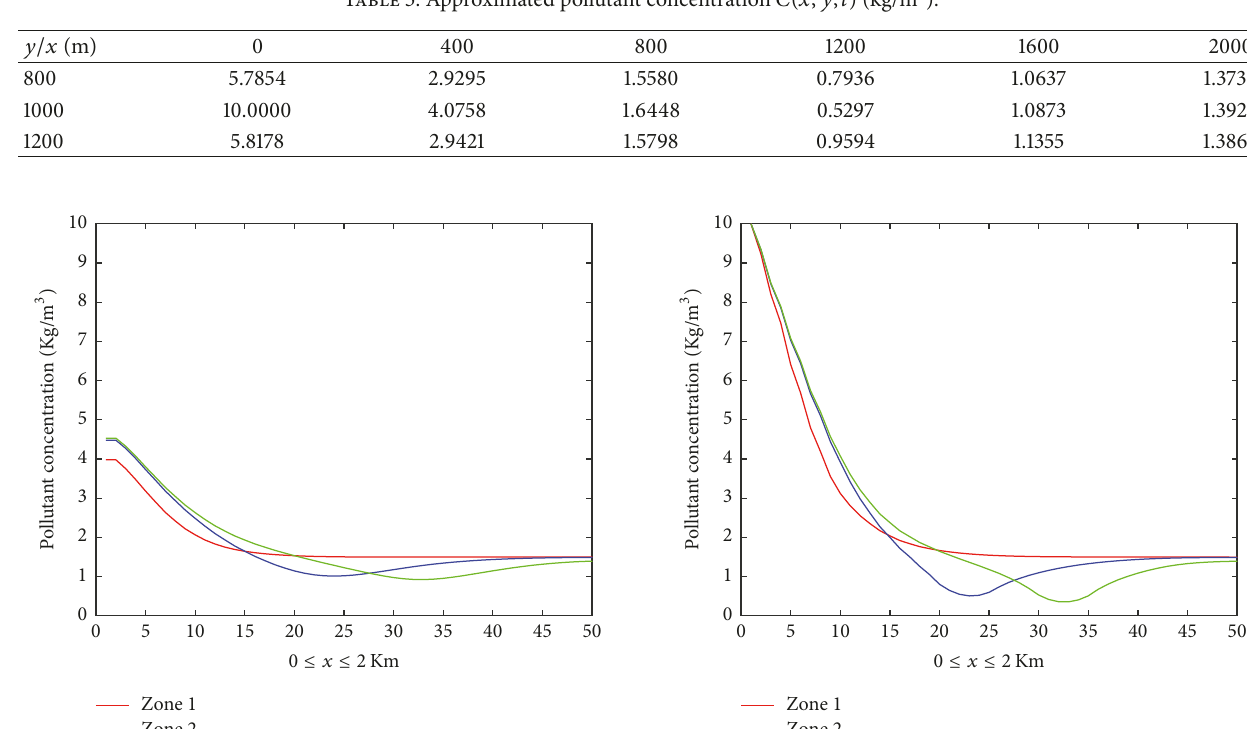
Table 5: Approximated pollutant concentration 𝐶(𝑥,𝑦,𝑡) (kg/m 3 ).